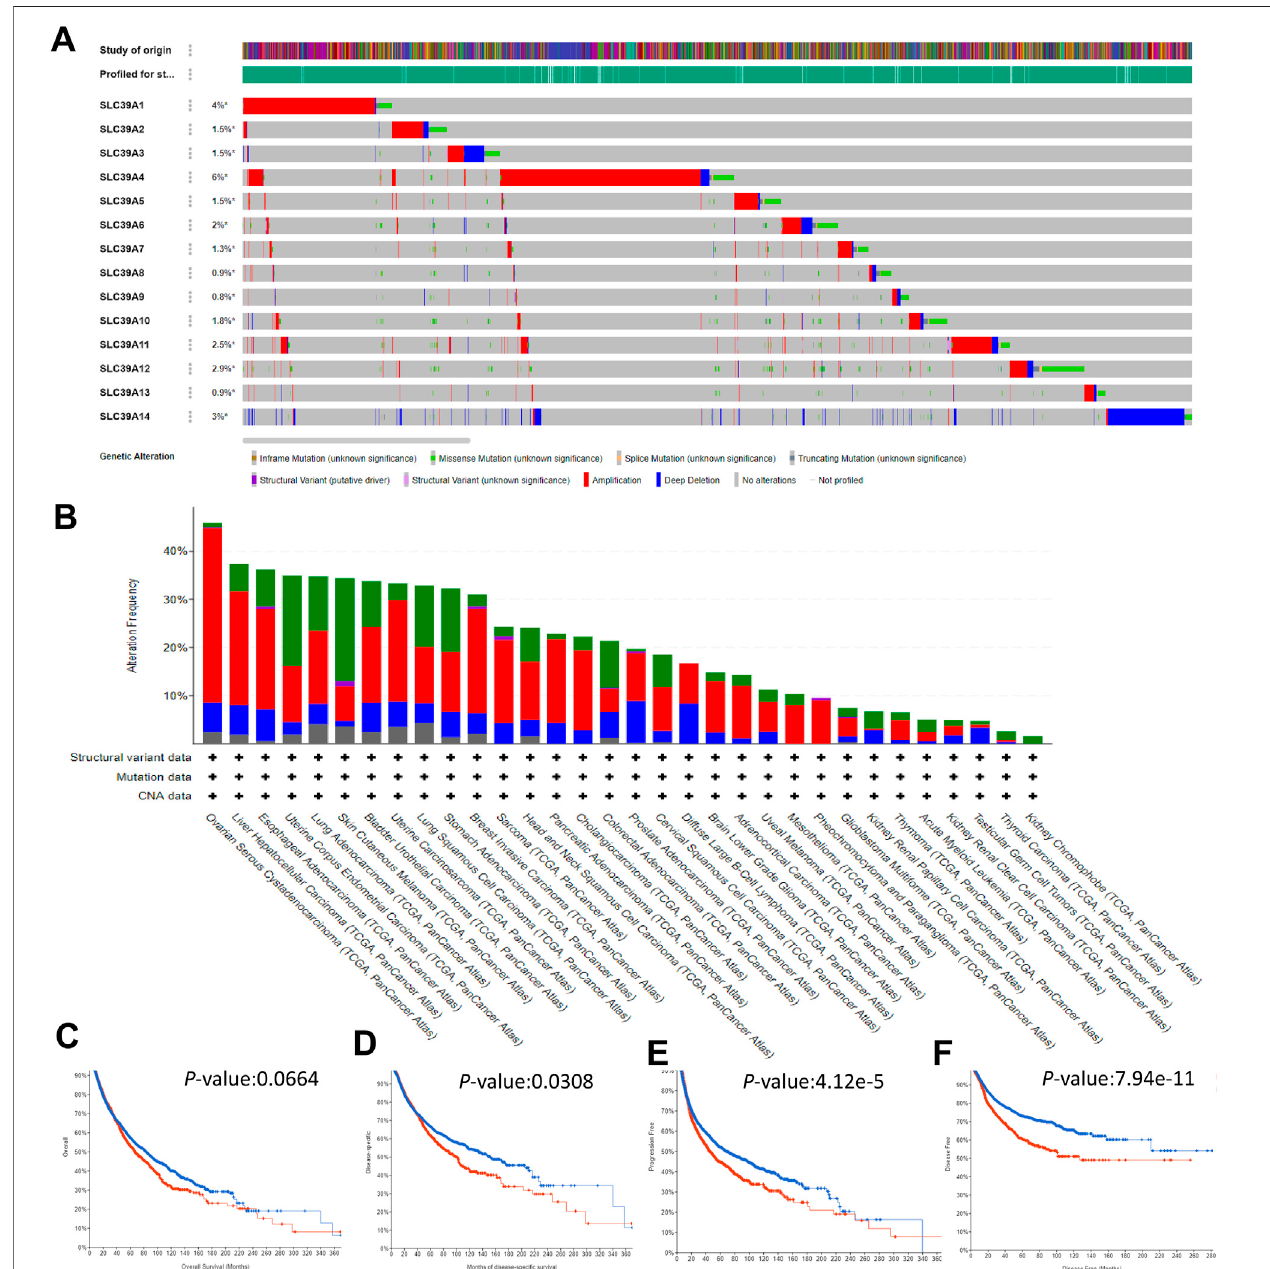
FIGURE 3 | Mutation landscape of the SLC39A family genes in pan-cancer derived from the cBioPortal platform. (A) OncoPrint summary of alteration on SLC39A family genes in 10,967 numbers of samples in 32 studies of the pan-cancer atlas. The mutation frequency was shown as green for mutations, red for fusions, blue for sions, and black for multiple mutations. (B) Rectangular graph of the general mutation counts of SLC39A family genes in the pan-cancer atlas. The X - and Y -axis represent the mutation frequency of SLC39A family genes and cancer type, respectively. It was shown as green for missense mutations, violet for fusions, deep blue for truncating, and blue for no mutations. (C) Kaplan – Meier chart of OS of pan-cancer with and without SLC39A family gene mutation. (D) Kaplan – Meier chart of DDS of pan-cancer with and without SLC39A family gene mutation. (E) Kaplan – Meier chart of PFS of pan-cancer with and without SLC39A family gene mutation. (F) Kaplan – Meier chart ofDFS ofpan-cancer withand without SLC39A family gene mutation. Thered lineand the blue line represent high and low expression, respectively. The Cox p -value cut-off value was set to 0.05.